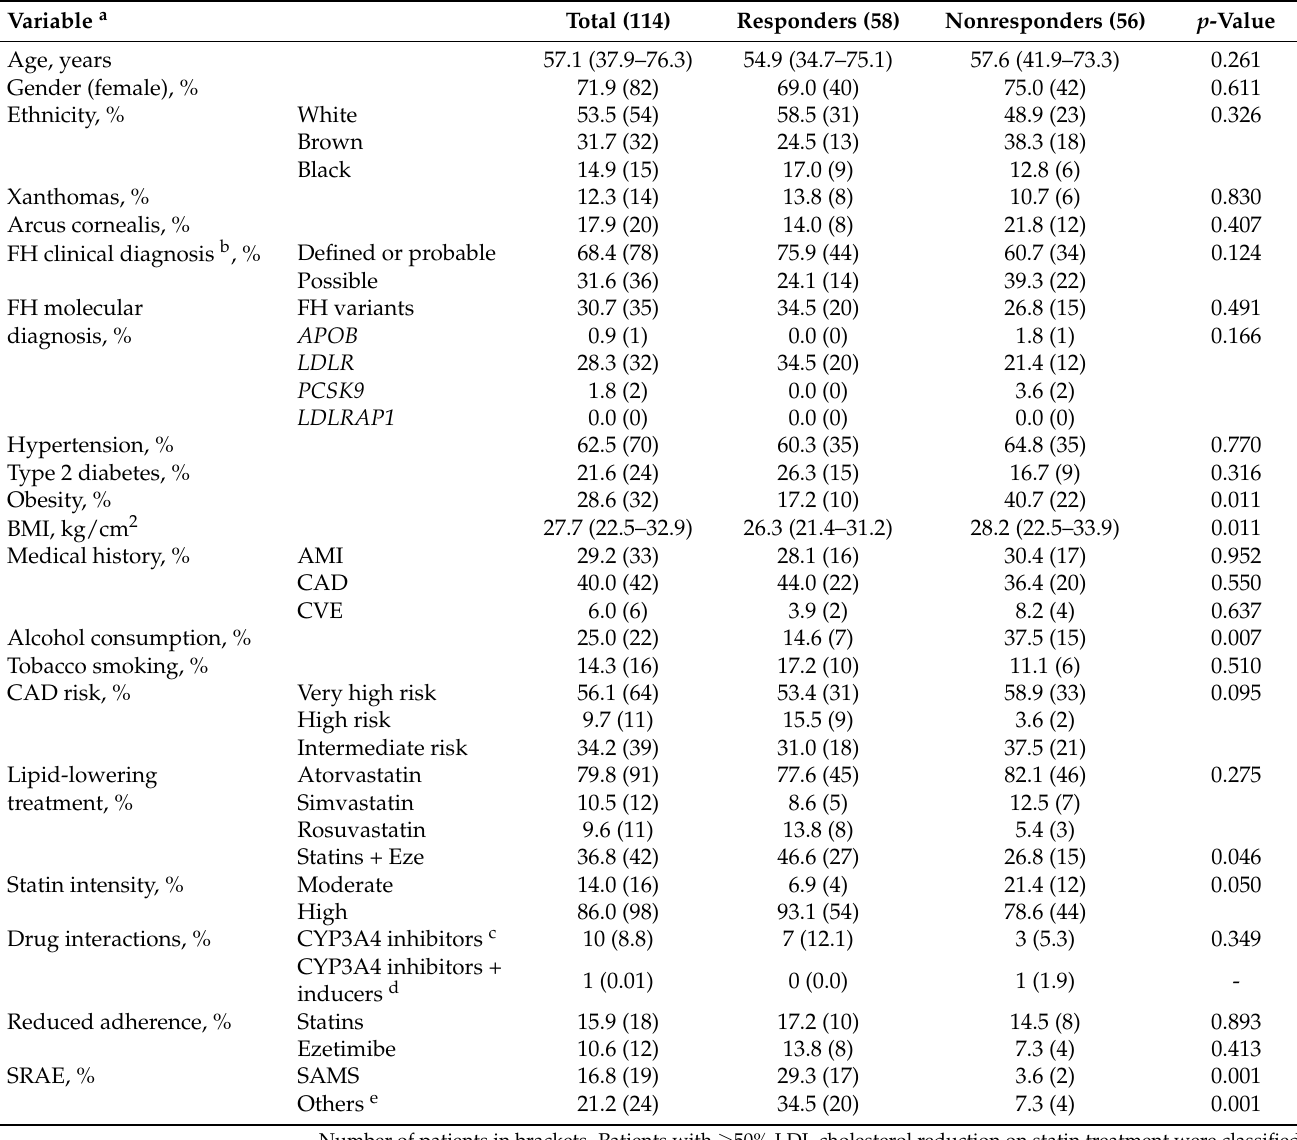
Number of patients in brackets. Patients with ≥ 50% LDL cholesterol reduction on statin treatment were classified as responders. Categorical variables were compared by chi-square test. Continuous variables are shown as median and interquartile range and were compared by Mann–Whitney test. AMI: acute myocardial infarction; BMI: body mass index; CAD: coronary artery disease; CVE: cerebrovascular event; Eze: ezetimibe; SRAE: statin-related adverse events a Data were not available for ethnicity (13 patients), arcus cornealis (two patients), hypertension (two patients), diabetes (three patients), BMI (four patients), obesity (two patients), history of AMI (one patient), CAD (nine patients), CVE (14 patients), tobacco smoking (two patients), alcohol consumption (26 patients), and age (two patients). b DCLN modified criteria. c All patients in this category used the CYP3A4 inhibitor amlodipine. d All patients in this category used the CYP3A4 inhibitor amlodipine and the CYP3A4 inducer carbamazepine. e Including also stomach pain (four patients), diarrhea (one patient), urinary tract infection (one patient), increased hepatic enzymes (one patient), and joint pain (one